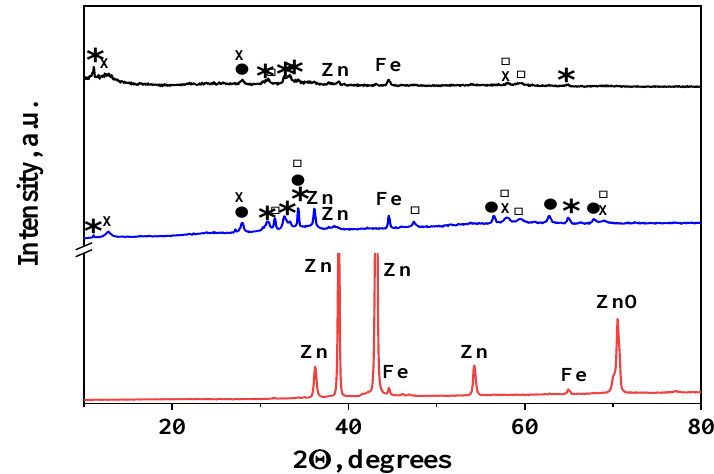
Figure 8. XRD patterns of corrosive treated ordinary Zn (up) as well as of ZnCSp coating before (down) and after (middle) corrosion treatment. * —Zn 5 (OH) 8 Cl 2 · H 2 O; • —Zn(OH) 2 ; (cid:3) —ZnO; x—Zn 5 (OH) 6 (CO 3 ) 2 .